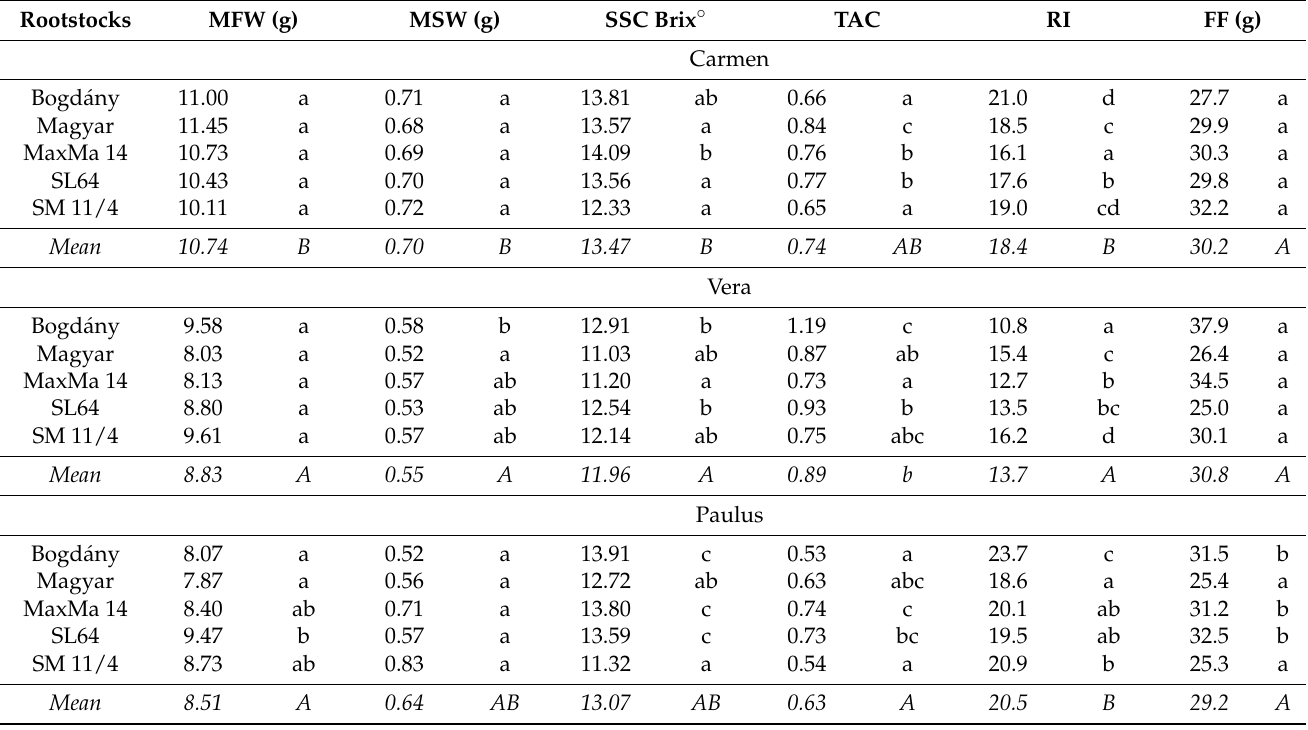
Table 7. Fruit characteristics of varieties on different rootstocks in